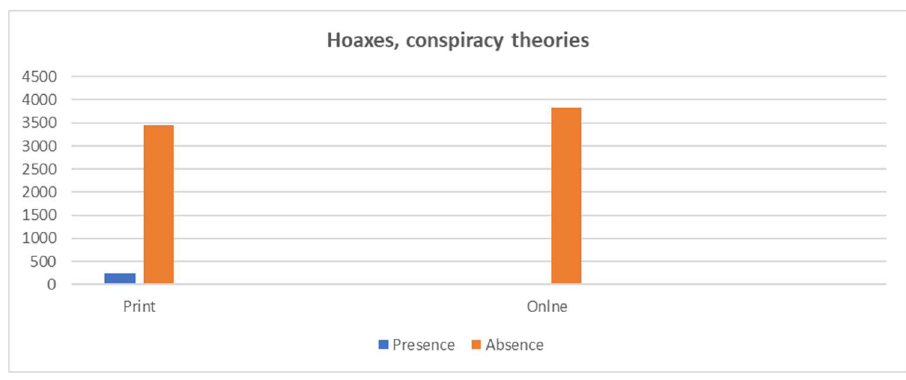
Figure 7. Presence of misinformation in print and online media.